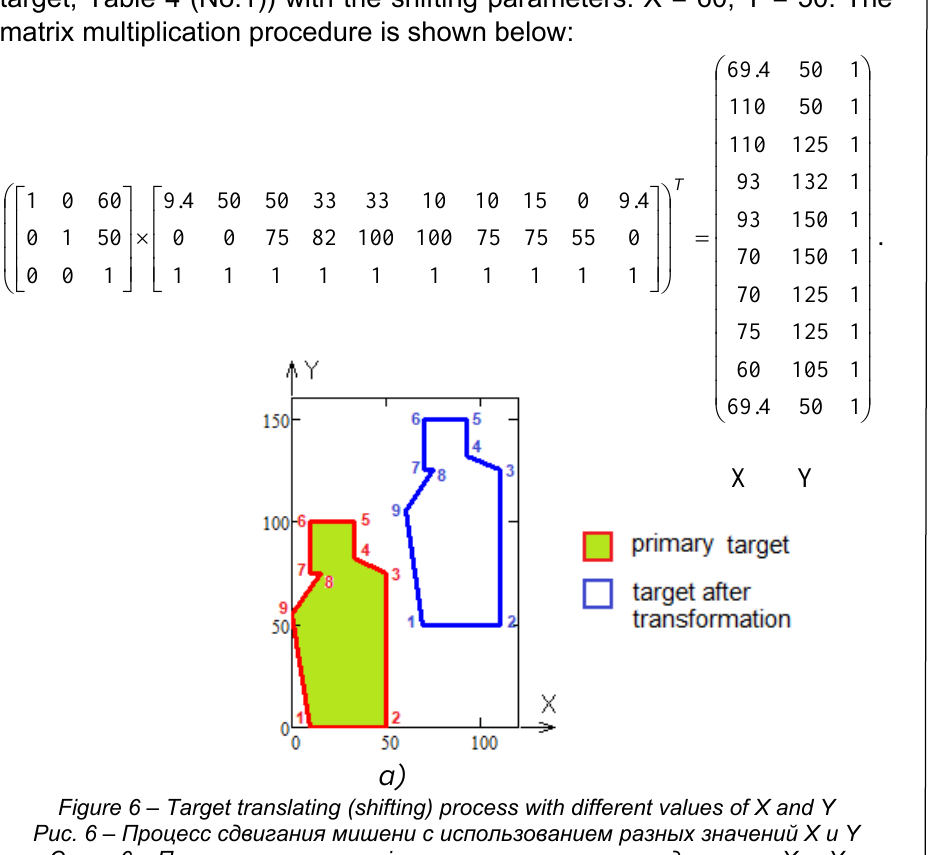
Figure 6 – Target translating (shifting) process with different values of X and Y Рис . 6 – Процесс сдвигания мишени с использованием разных значений X и Y Слика 6 – Поступак транслације мете с различитим вредностима X и